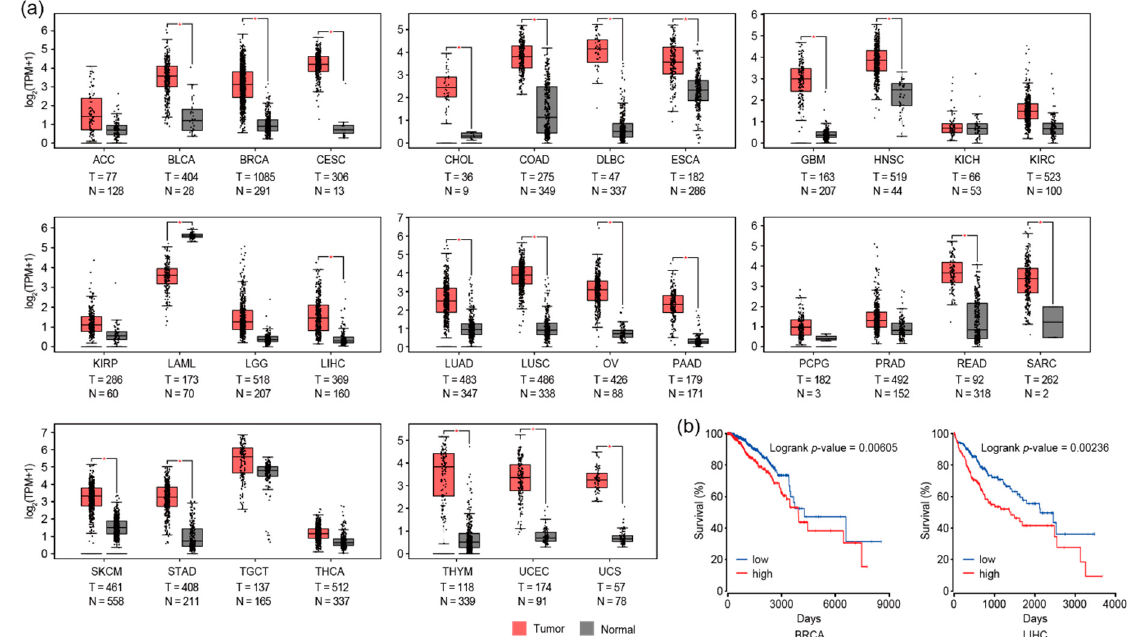
Figure 4. Expression levels of the RAD51 gene in various types of cancer. ( a ) Box plots show normalized expression levels (transcripts per kilobase million, TPM) of the RAD51 gene in tumor tissues and corresponding normal controls. * p -value < 0.01. ( b ) The prognosis of patients diagnosed with BRCA or LIHC was estimated and plotted in Kaplan–Meier survival plots. The patients were divided into two groups (high and low) based on the expression level of the RAD51 gene.